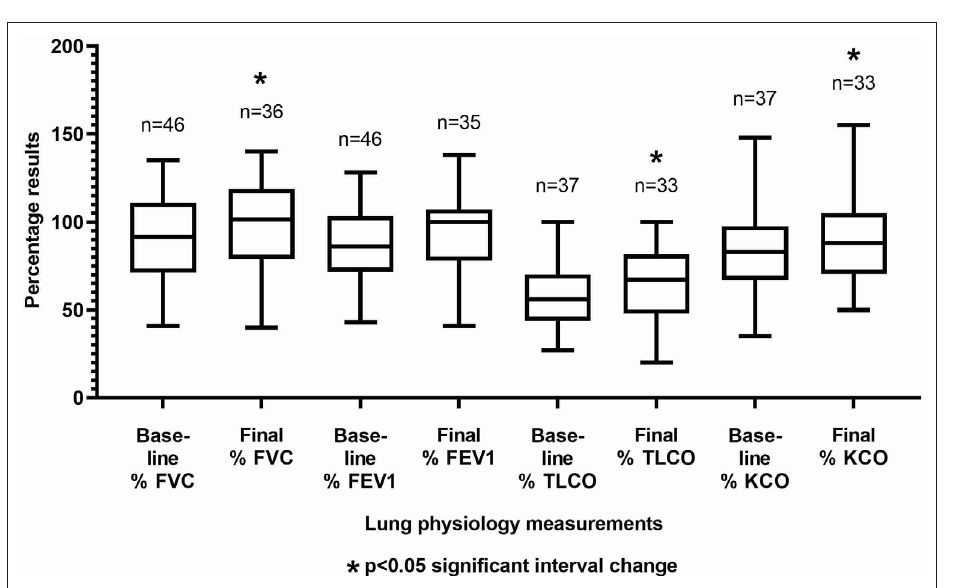
Figure 3 Spirometry test result changes over interval of Bristol Interstitial Lung Disease clinic treatment for nitrofurantoin- induced interstitial lung disease. FVC increased by median 5.00% (95% CI = –0.79 to 15.18). FEV1 increased by mean 2.93% (95% CI = –4.86 to 10.72). TLCO increased by mean 7.70% (95% CI = 2.49 to 12.91). KCO increased by mean 7.10% (95% CI = 2.27 to 11.94). FEV1= forced expiratory volume in 1 second. FVC = forced vital capacity. KCO = TLCO correction for haemoglobin. TLCO = diffusion capacity of the